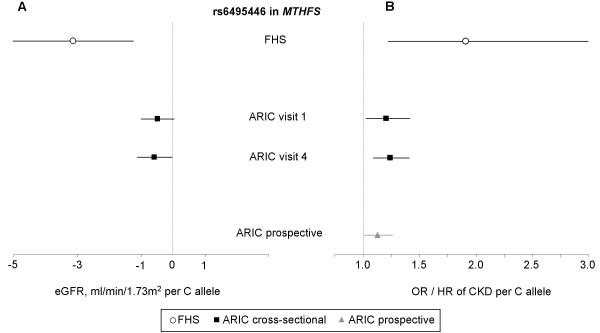
Results from multivariable adjusted association analyses of rs6495446 in MTHFS and both eGFR (panel A) and CKD (panel B) in FHS and ARIC. Risk estimates refer to each additional copy of the C allele. For ARIC, odds ratios of CKD per risk allele and the hazard ratio of kidney disease progression per risk allele are presented on the same scale. Horizontal bars represent 95% confidence intervals. Abbreviations: eGFR: estimated glomerular filtration rate, OR: odds ratio, CKD: chronic kidney disease.